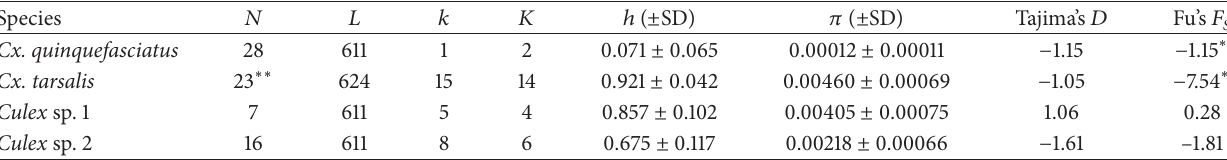
Table 1: Summary of genetic diversity indices and results of neutrality tests (Tajima’s 𝐷 and Fu’s 𝐹 𝑆 ) in the mitochondrial COI gene segment of Culex